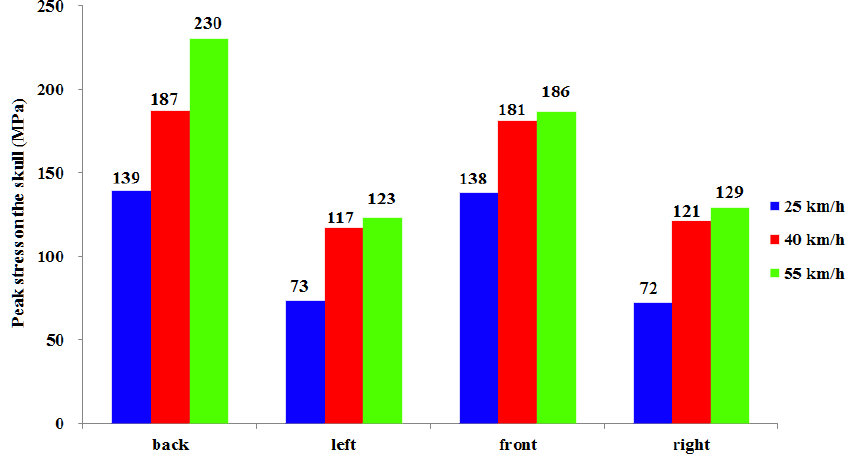
Figure 7. Peak stress on the skull at different collision parameters.